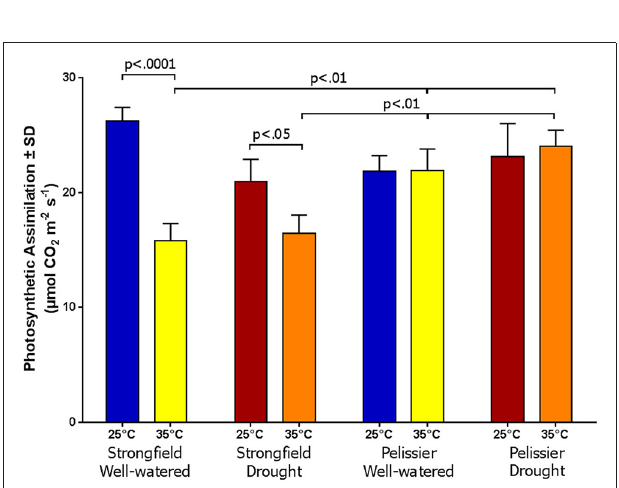
FIGURE 8 | Photosynthesis is Strongfield and Pelissier at two leaf temperatures and watering conditions.